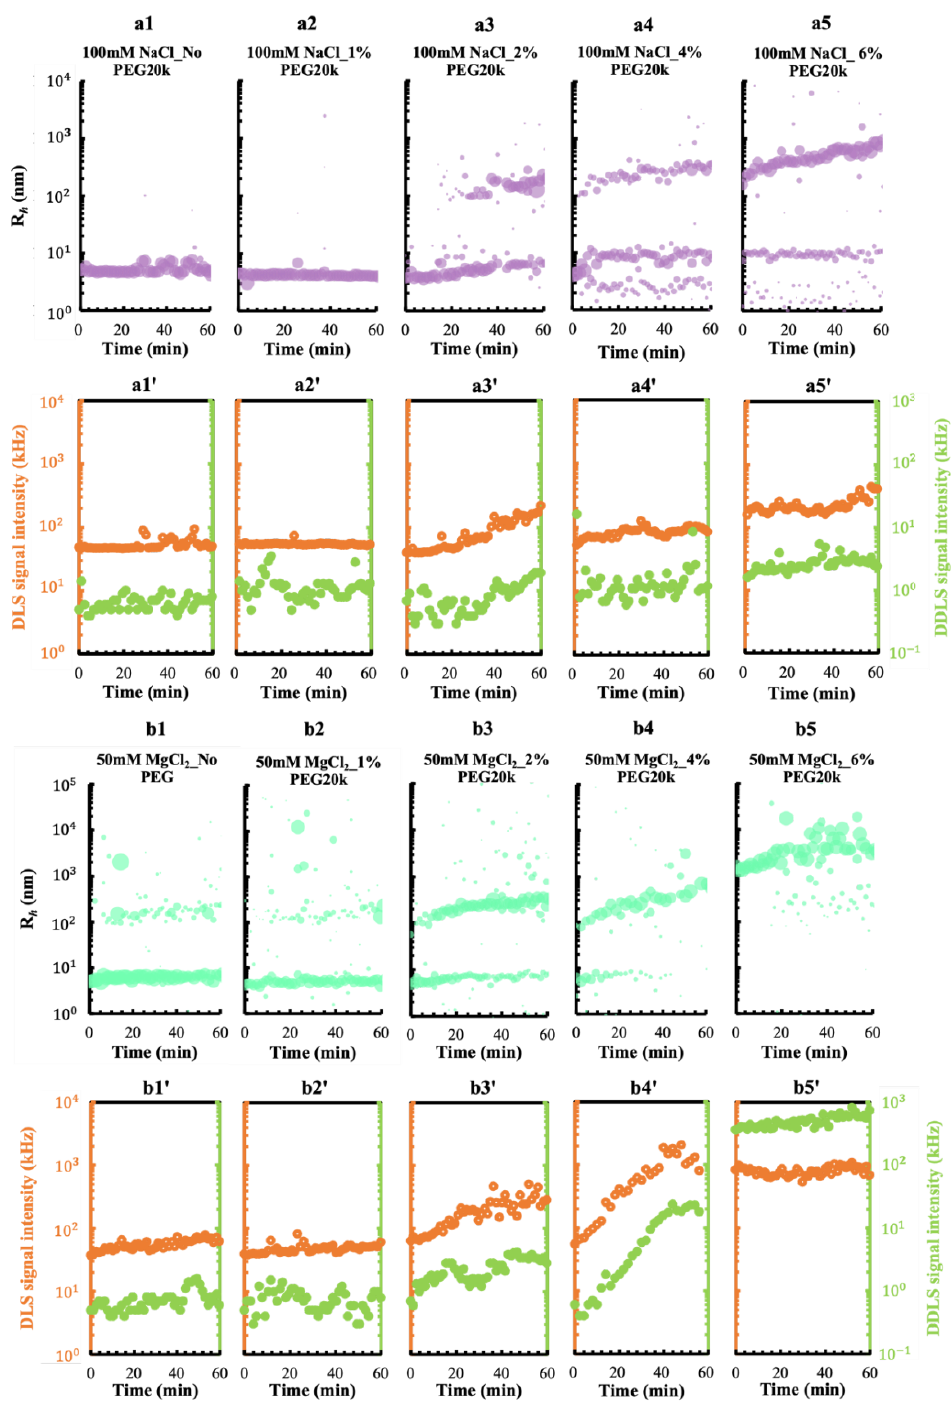
Figure 6. Time-resolved monitoring of GI phase transition in context of varying crowding environ- ments. ( a1 – a5 ) Kinetic evolution of the hydrodynamic radii and ( a1 (cid:48) – a5 (cid:48) ) corresponding DLS (left Y-axis, orange symbol)/DDLS (right Y-axis, green symbol) signal intensities of a 2 mg/mL GI solution mixed with a gradient of PEG20k in a buffer containing 100 mM NaCl. ( b1 – b5 ) Kinetic evolution of the hydrodynamic radii and ( b1 (cid:48) – b5 (cid:48) ) corresponding DLS/DDLS signal intensities of a 2 mg/mL GI solution mixed with a gradient of PEG20k in a buffer containing 50 mM MgCl 2